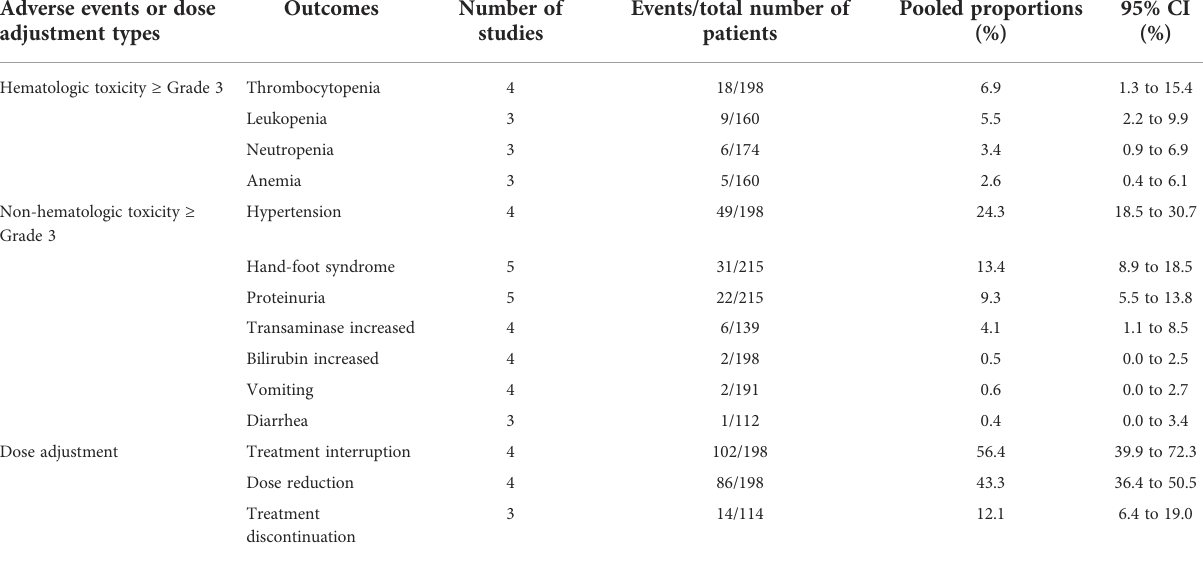
TABLE 3 Pooled analysis of adverse events (grades 3 – 4) and dosage adjustment. Adverse events or